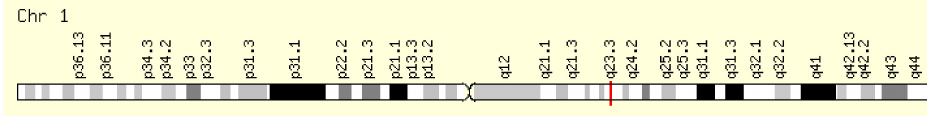
Figure 4. Localization of the NOS1AP gene